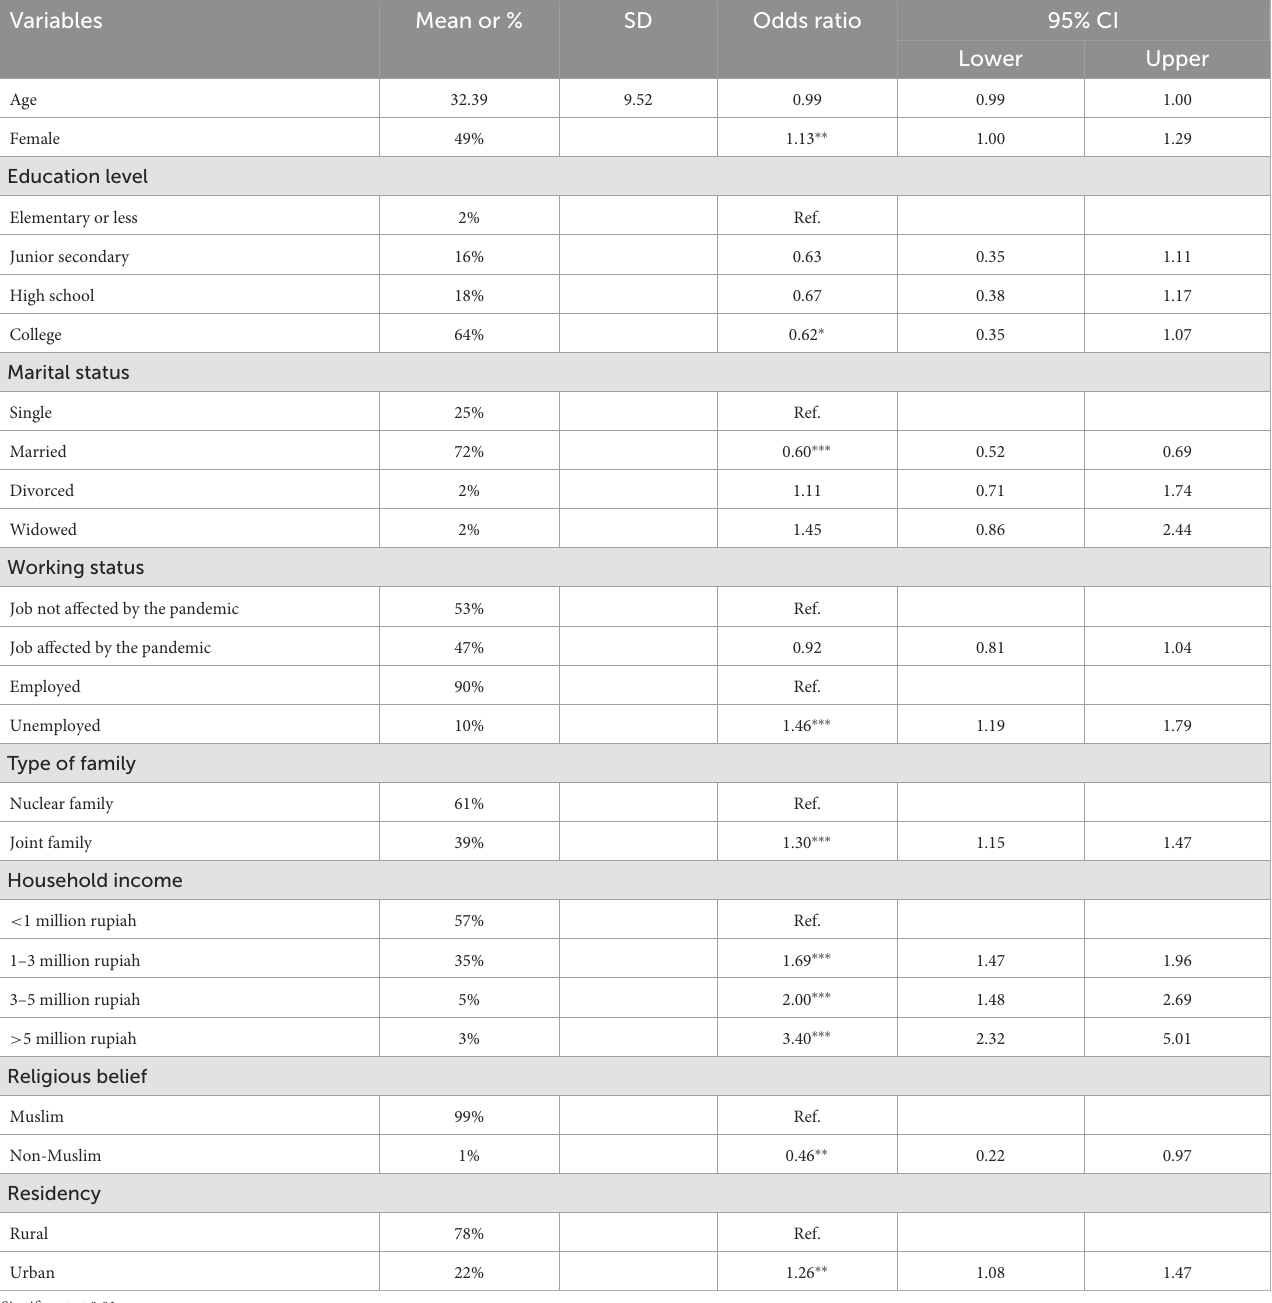
TABLE 1 Sample characteristics and bivariate correlation with COVID-19 vaccine hesitancy.